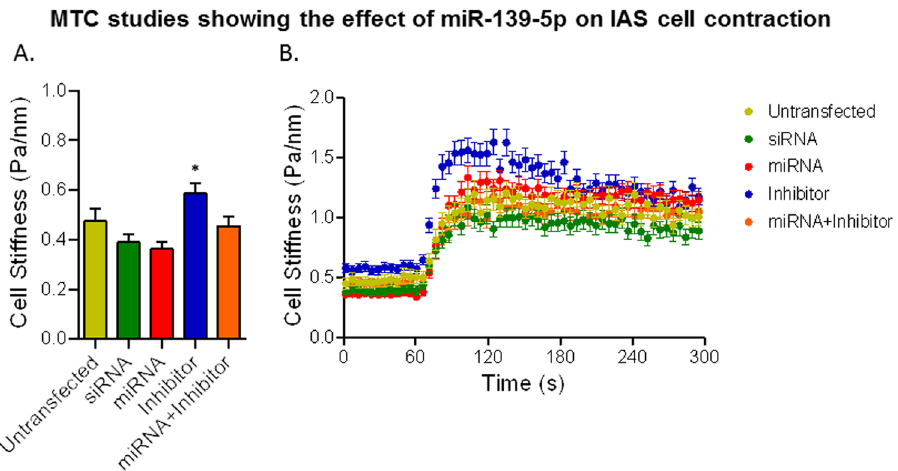
Figure 7. MTC data showing the effect of miRNA- and anti-miRNA-139-5p. ( A ) Baseline cell stiffness of individual IAS SMCs before and after 72 h transfection with ROCK2 siRNA, miRNA-139-5p, anti-miRNA- 139-5p (inhibitor), and miRNA-139-5p plus the inhibitor. SMCs transfected with ROCK2 siRNA and miRNA- 139-p showed decreases in baseline cell stiffness (basal tone) while cells transfected with anti-miRNA-139-5p showed increases in basal tone. Increased basal tone in response to anti-miRNA-139-5p was attenuated with co-transfection with miRNA-139-5p. Data are presented as Mean ± s.e.m. (n = 89–149 individual cell measurements). ( B) Dynamic changes the stiffness of IAS SMCs in response to 100 nM U46619. Consistent with the rat smooth muscle data, anti-miRNA-139-5p causes faster and greater cell stiffening in response to